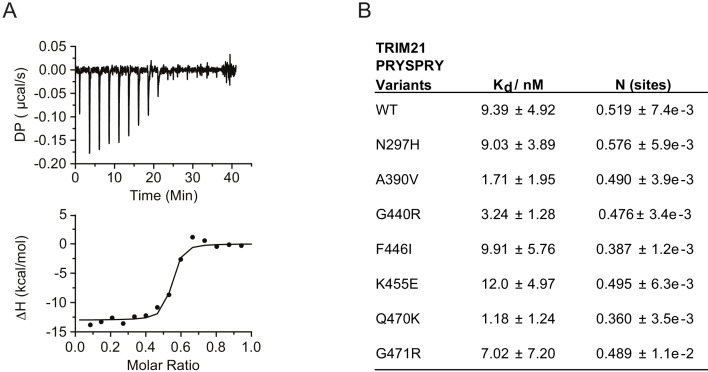
PRYSPRY missense variants maintain antibody binding.(A) Representative Isothermal titration calorimetry (ITC) trace of IgG Fc against WT TRIM21 PRYSPRY fitted to the one set of sites model. (B) Summary of PRYSPRY variant binding affinities to IgG Fc. Consistent with known binding mode, TRIM21 PRYSPRY binds IgG with a stoichiometry of 2:1 (Keeble et al., 2008). Data provided in Figure 3—source data 1.10.7554/eLife.48339.008Figure 3—source data 1.